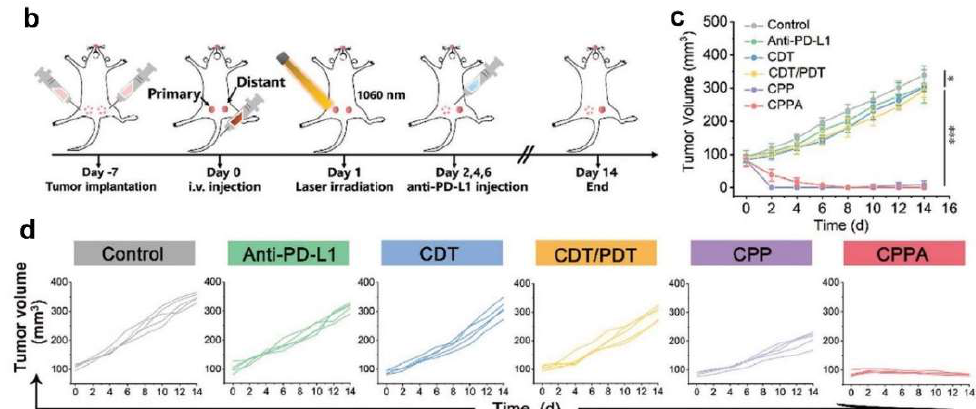
Figure 5. ( a ) A schematic illustration of FeWOx-PEG nanoadjuvant-mediated CDT/PDT/PTT under NIR-II laser irradiation and antitumor immunity effect amplification via combining ROS/PTT-triggered ICD with immune checkpoint blockade therapy under the imaging guidance. ( b ) A schematic diagram combining the FeWOx-PEG nanoadjuvant with the anti-PD-L1 strategy for inhibiting a distant tumor on female BALB/c mice. ( c ) The tumor volume changes of the primary tumor after various treatments. ( d ) The tumor volume changes of the distant tumor in six groups after various treatments. Reproduced with permission from [78]. Copyright 2022, Wiley-VCH. A p -value < 0.05 was considered statistically significant, * p < 0.05, *** p < 0.001.